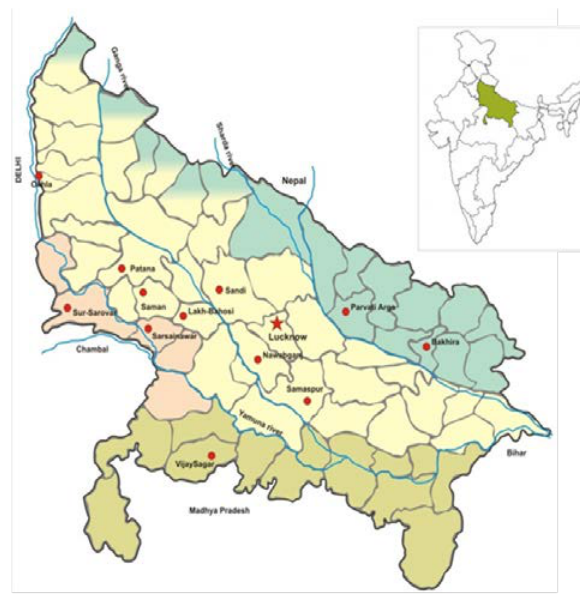
Fig. 1. Map of Uttar Pradesh showing different protected wetlands in four different ecozones, namely, Tarai plain, Gangetic plain, Semi-arid western plain and Vindhyan Bundelkhand region. Inset map courtesy: Himalayan